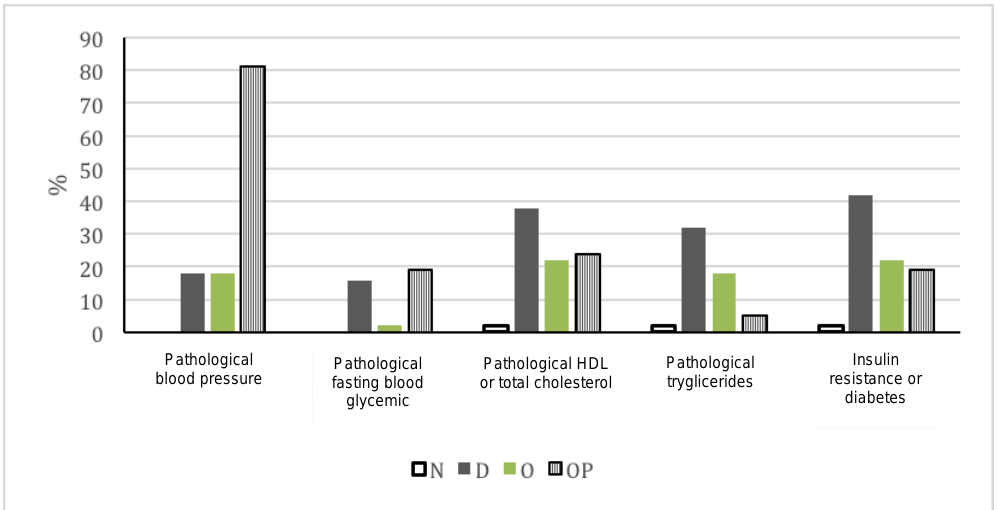
Figure 1. Pathological components of metabolic syndrome in pediatric groups (N = normal weight children; D = disabled patients; O = obese subjects) and older patients (OP= older patients).